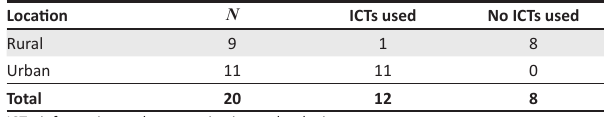
TABLE 4: Sample description.